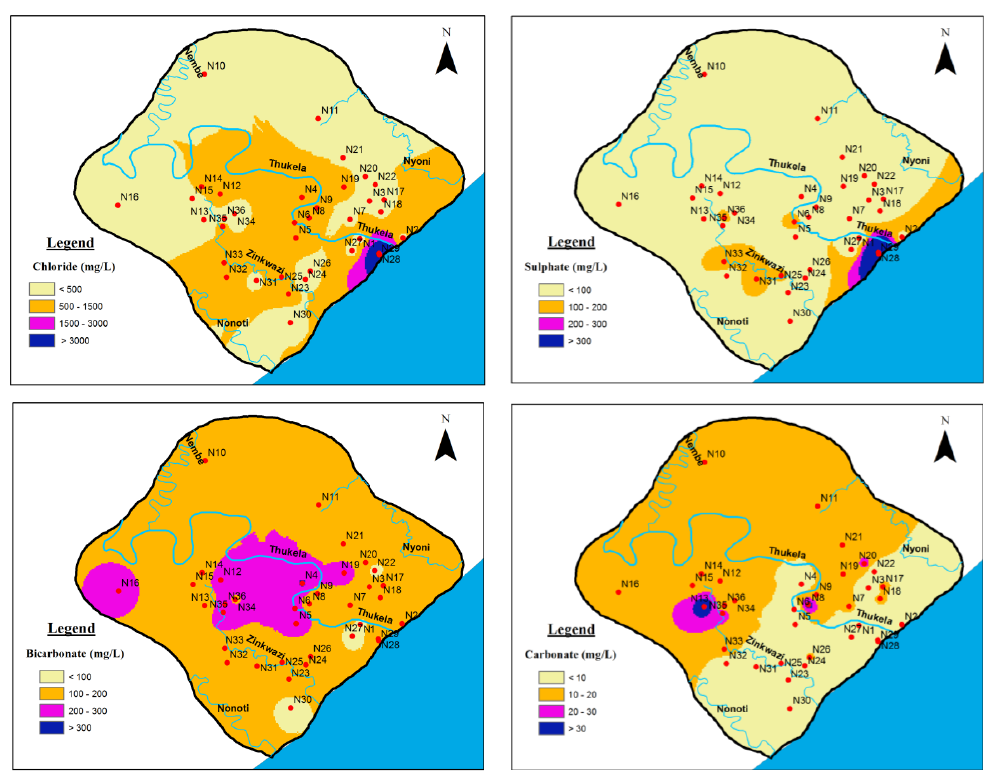
Figure 5. Spatial distribution of major anions.